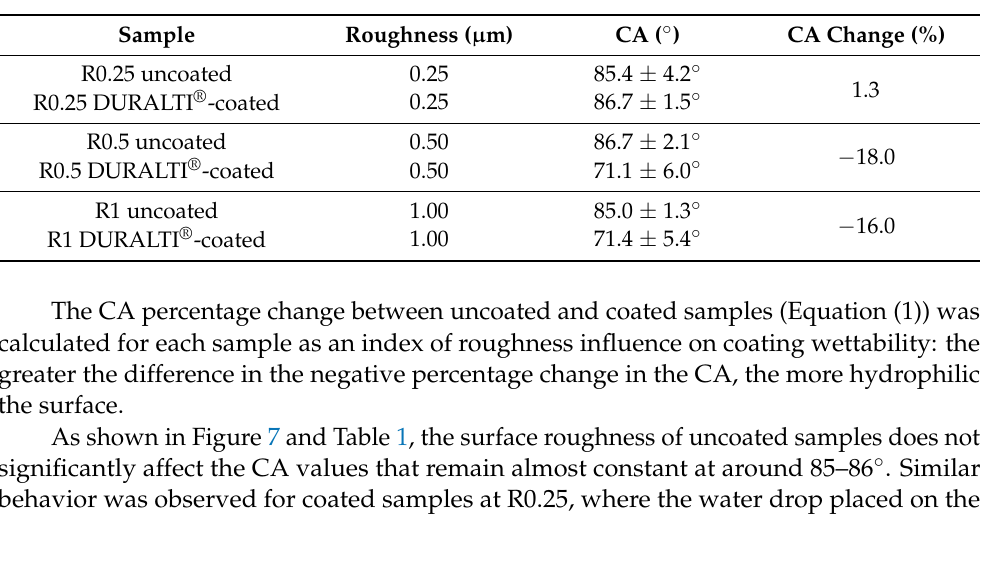
Figure 7. Images of steady-state water CA of uncoated and DURALTI ® -coated aluminum disks. Table 1. Roughness profile and CA measurements of uncoated and coated aluminum disks. The standard deviation was computed considering ten repeated tests performed on each